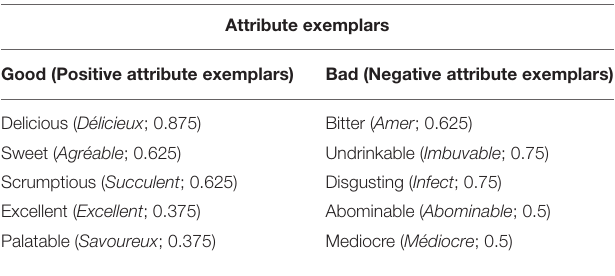
TABLE 2 | Attribute exemplars used in the experiment (original French words and their respective frequencies are given in parentheses).